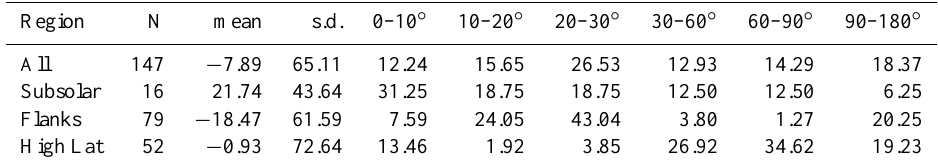
Table 6. Distribution of angular differences in the Southward IMF case (IMF clock angle between − 165 ◦ and 165 ◦ ). Format as in Table 3. Region N All